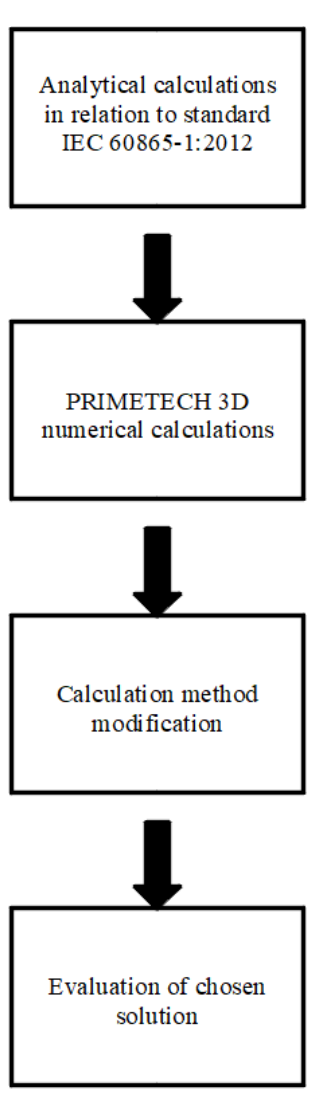
Figure 11. Flow chart of conducted work leading to final solution.